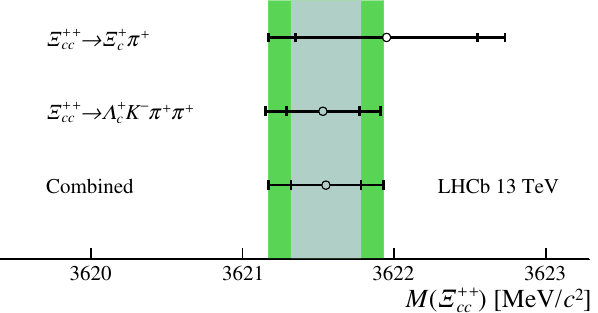
Figure 2 . Measured (cid:4) ++ mass values and uncertainties obtained with the decay modes cc (cid:4) ++ ! (cid:3) + K (cid:0) (cid:25) + (cid:25) + and (cid:4) ++ ! (cid:4) + (cid:25) + . The combination is performed using the best linear unbi- cc c cc c ased estimator [53, 54]. The inner error bars represent statistical uncertainties and the outer error bars represent the quadratic sum of statistical and systematic uncertainties. The inner and outer green bands correspond to the uncertainties on the averaged